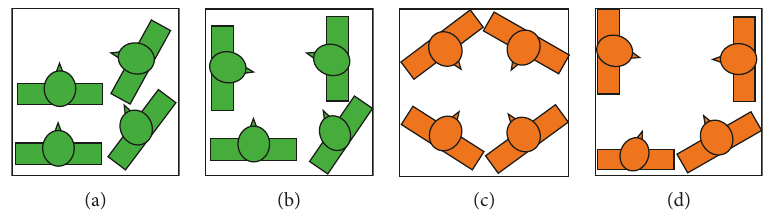
Figure 6: 4 p/m 2 , green: remaining silent, orange: speaking, door at the top.